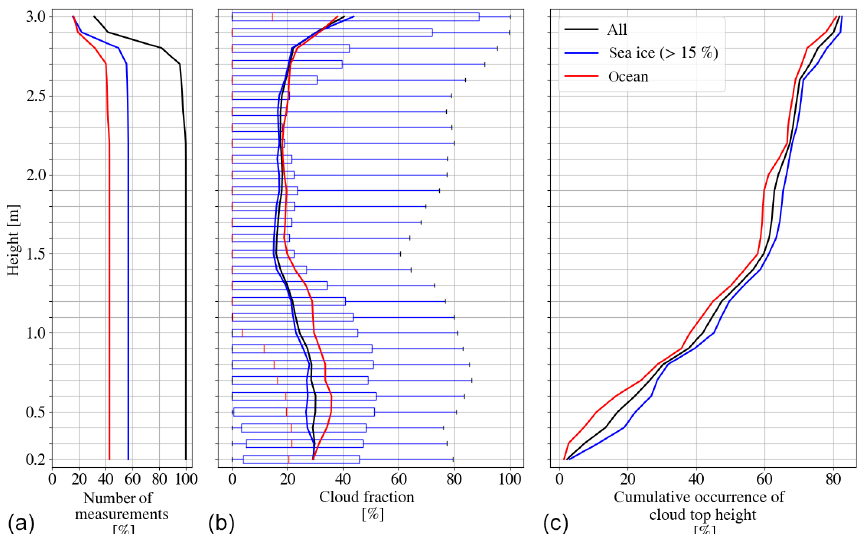
Figure 8. Height-dependent cloud top height and cloud fraction (CF) on intervals of 100m. The interval center is written in the y ordinate. (a) number of measurements; (b) solid lines describe the total averaged cloud fraction at each height over all profiles; box–whisker plots of cloud fraction averaged over 20min with percentiles of 10%, 25%, 50%, 75%, and 90% from left to right; (c) cumulative occurrence of averaged cloud top height. The sea ice fraction is derived from satellite observations by AMSR2.